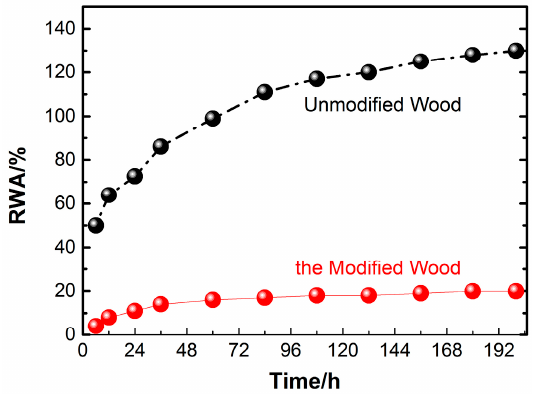
Figure 4. Comparison of the reduction in water absorptivity (RWA) of the unmodified wood (black curve) veneer and the modified wood veneer under the optimized monomers system (red curve).